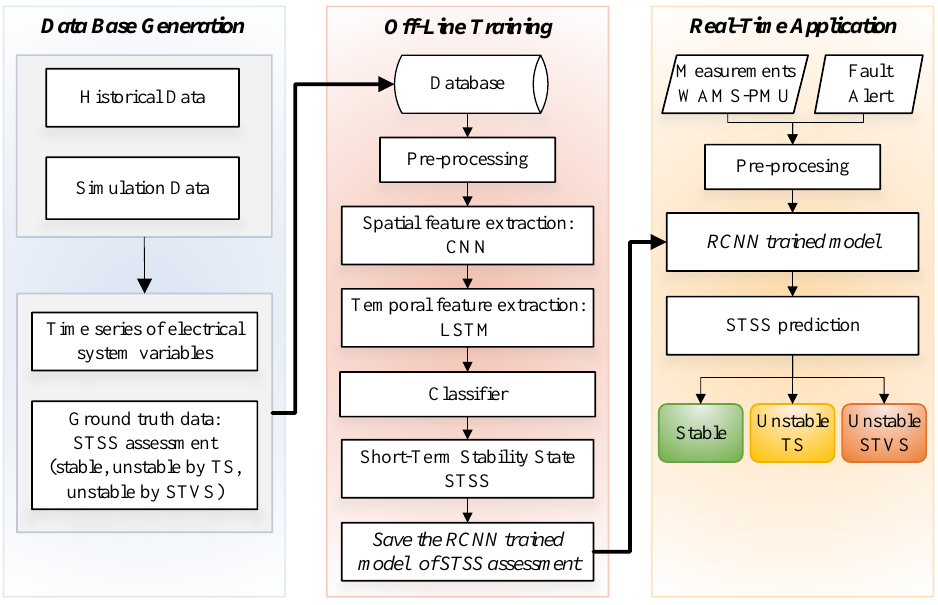
Figure 4. Flowchart of the proposed RCNN-based methodology and its real-time application.